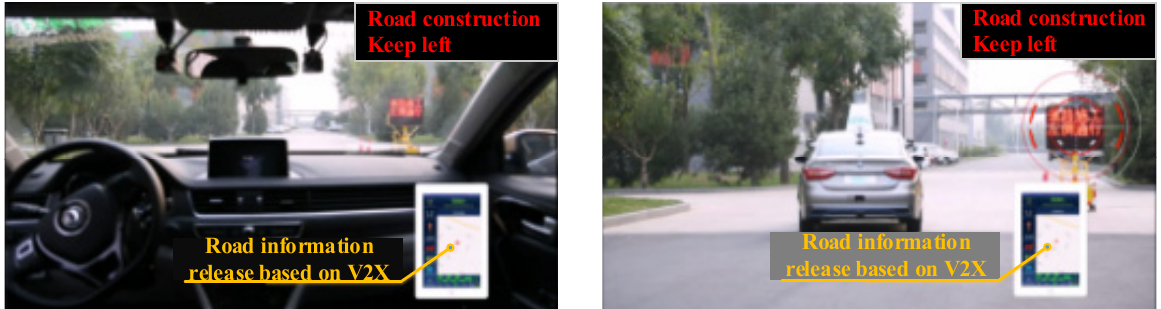
Figure 24. Road information publishing based on V2X.